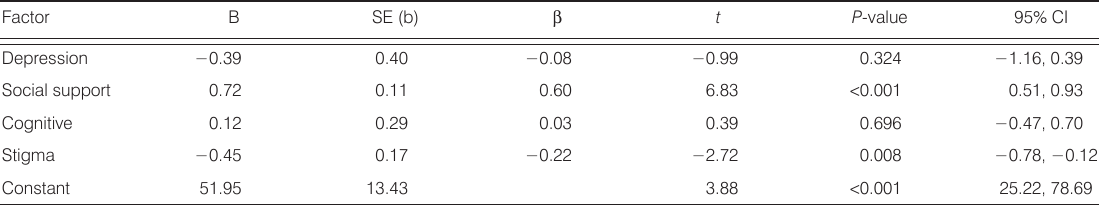
Table 4. Final model of factors predicting